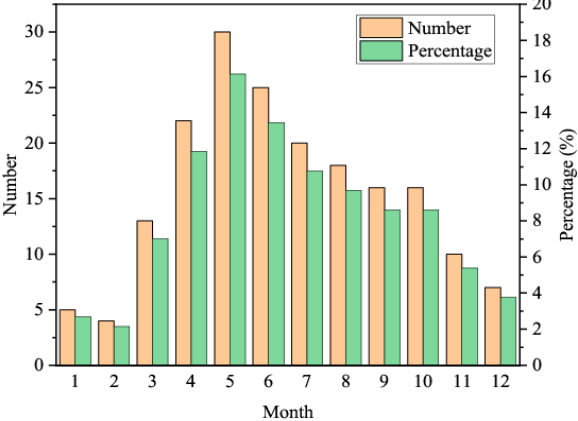
Figure 1. Monthly distribution of the number (orange) and percentage (green) of 186 COL events.